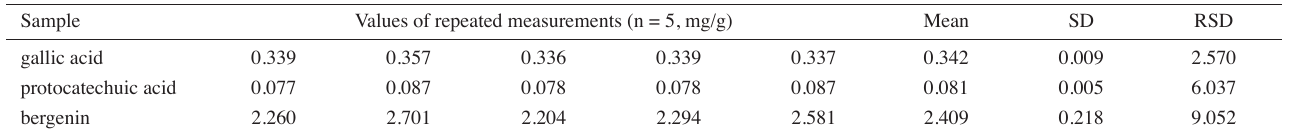
Tab. 2: Reproducibility of gallic acid, protocatechuic acid, and bergenin of the HPLC